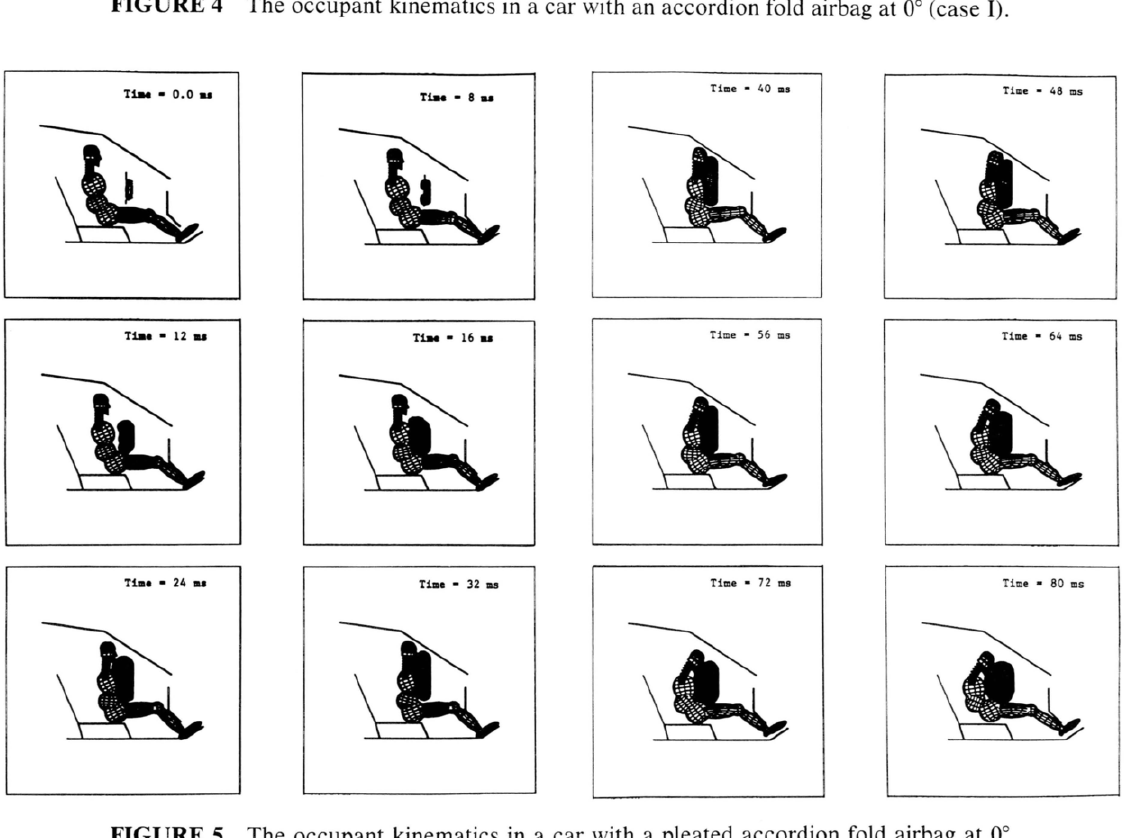
FIGURE 4 The occupant kinematics in a car with an accordion fold airbag at 0° (case 1),